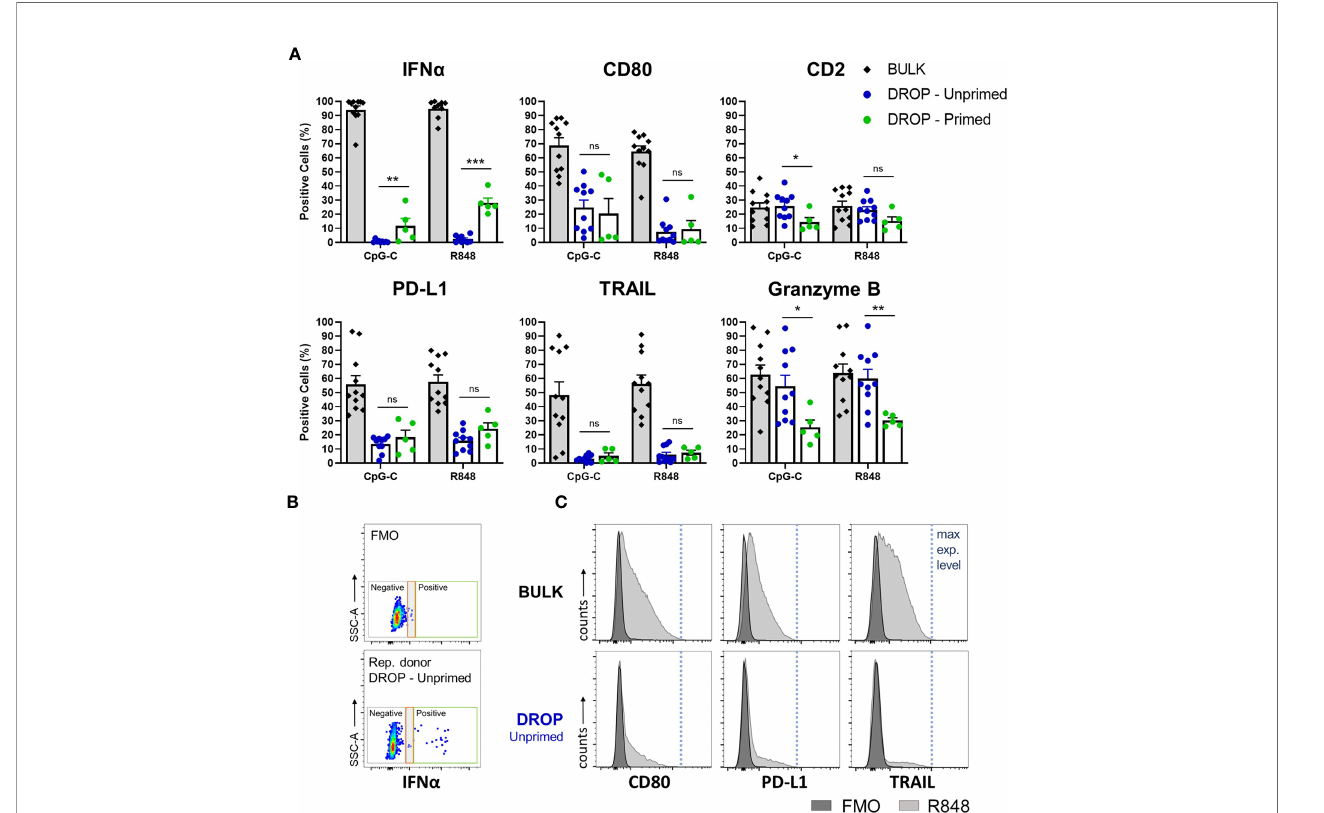
FIGURE 2 | Single-cell analysis reveals functional and phenotypical heterogeneity within single-activated pDCs. Freshly isolated pDCs were either primed or left unprimed, coated with IFN a Catch Reagent, and activated in bulk or droplets as described before. The pDCs were activated with 5 or 50 m g/mL CpG-C or R848, for bulk and droplet conditions respectively, for 18h. Next, pDCs were stained for viability, IFN a secretion, marker expression of CD80, PD-L1, TRAIL, CD2, granzyme B, and analyzed by fl ow cytometry. (A) Data represent mean percentages of IFN a -secreting and marker-expressing pDCs plotted against treatment condition; error bars indicate SEM; BULK n = 11; DROP-Unprimed n = 10; DROP-Primed n = 5 for both CpG-C and R848. (B) Dot plots depicting IFN a expression levels of FMO control and representative donor, DROP-Unprimed. Depicted in the colored boxes are negative events (gray) technological noise (red), and positive events (green). (C) pDCs were treated as described above. The histograms are representatives of expression levels of viable pDCs stimulated with R848 in either bulk or droplets from one donor, compared to FMO controls. Indicated with the blue dotted line are the maximum expression levels. Mann – Whitney test *p < 0.05, **p < 0.01, ***p < 0.001. ns, non-signi fi